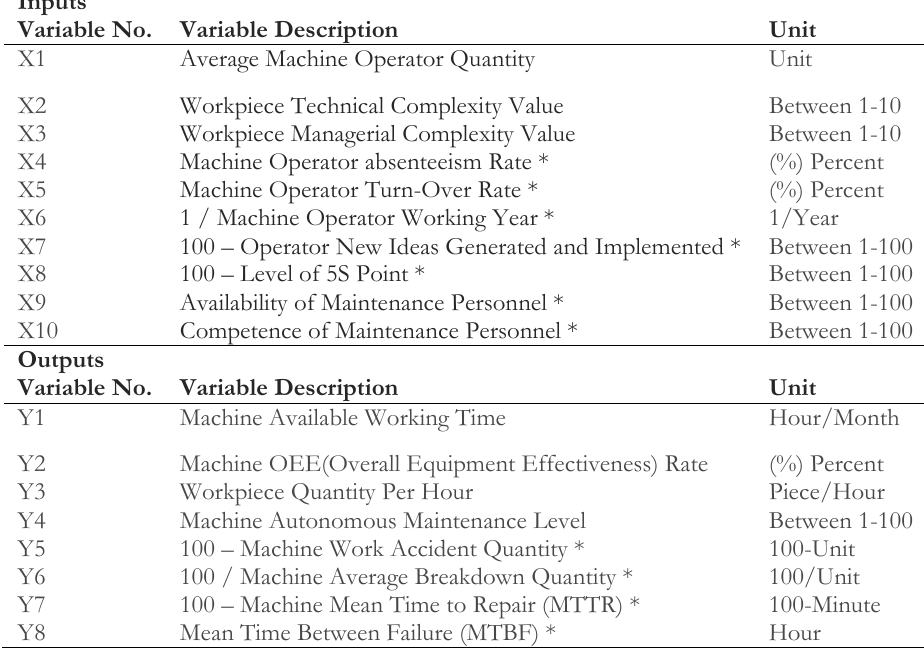
Table 1. Input and output variables.